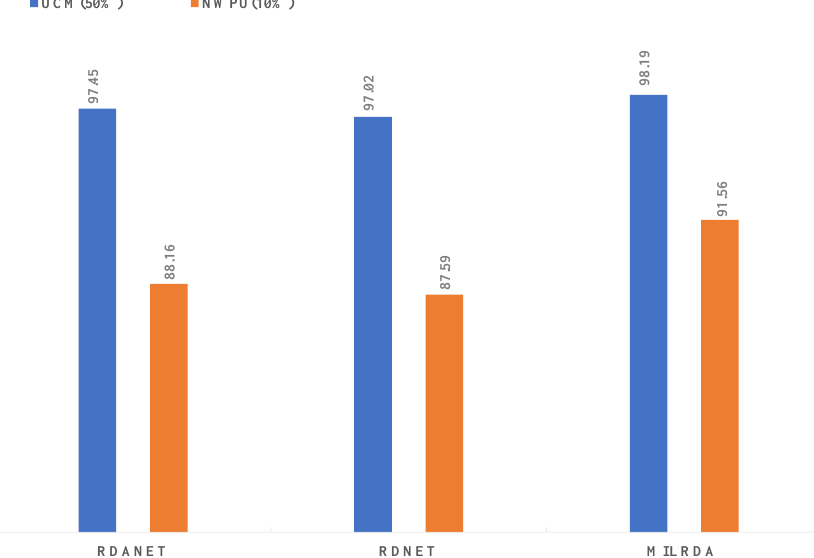
Figure 16. Effects of different structures on experimental effects. For the sake of observation, Figure 17 shows the feature maps of some categories. With the effect of MIL pooling based on channel attention, useless background information or other categories not related to bag-level labeling were suppressed. For example, for the category “tennis court,” the image contains multiple objects, such as trees, residential areas and roads. With MIL pooling, regions associated with true bag-level semantic labels were highlighted, and other instances were given reduced weights, showing the effectiveness of this pooling operation. Even in the absence of MIL pooling, our proposed method still produced good feature extraction results. This is because the CA mechanism in the feature extraction backbone can help represent the key local features while expanding the corresponding regions. However, this would include some useless background regions, further demonstrating the effectiveness of MIL pooling for suppressing the weights of irrelevant